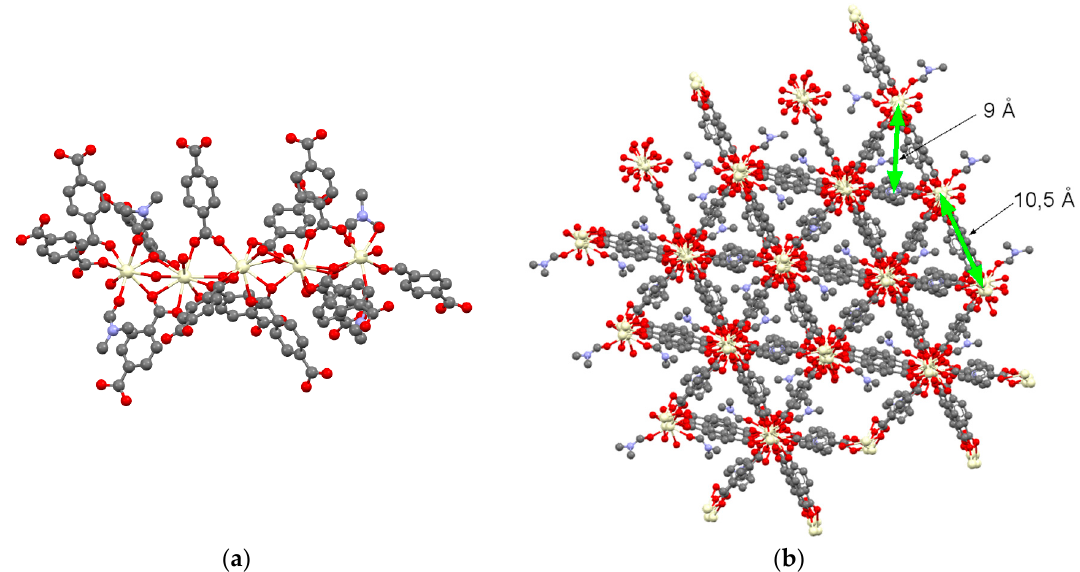
Figure 1. Structure of Ce 5 (BDC) 7.5 (DMF) 4 . ( a ) Depiction of the asymmetric unit, containing five Ce atoms, 18 BDC 2- , and four DMF molecules. Cerium, carbon, nitrogen, and oxygen atoms are pale yellow, black, blue, and red respectively; hydrogen atoms are omitted for the sake of clarity; ( b ) a view through the 11(cid:3364)0 direction. Meaningful distances are highlighted.